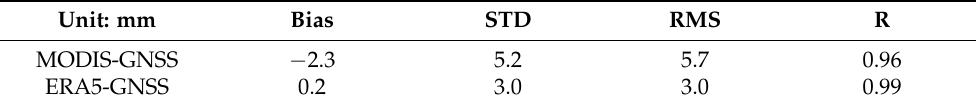
Table 1. Average accuracy of data pairs after removing outliers. Unit: mm Bias